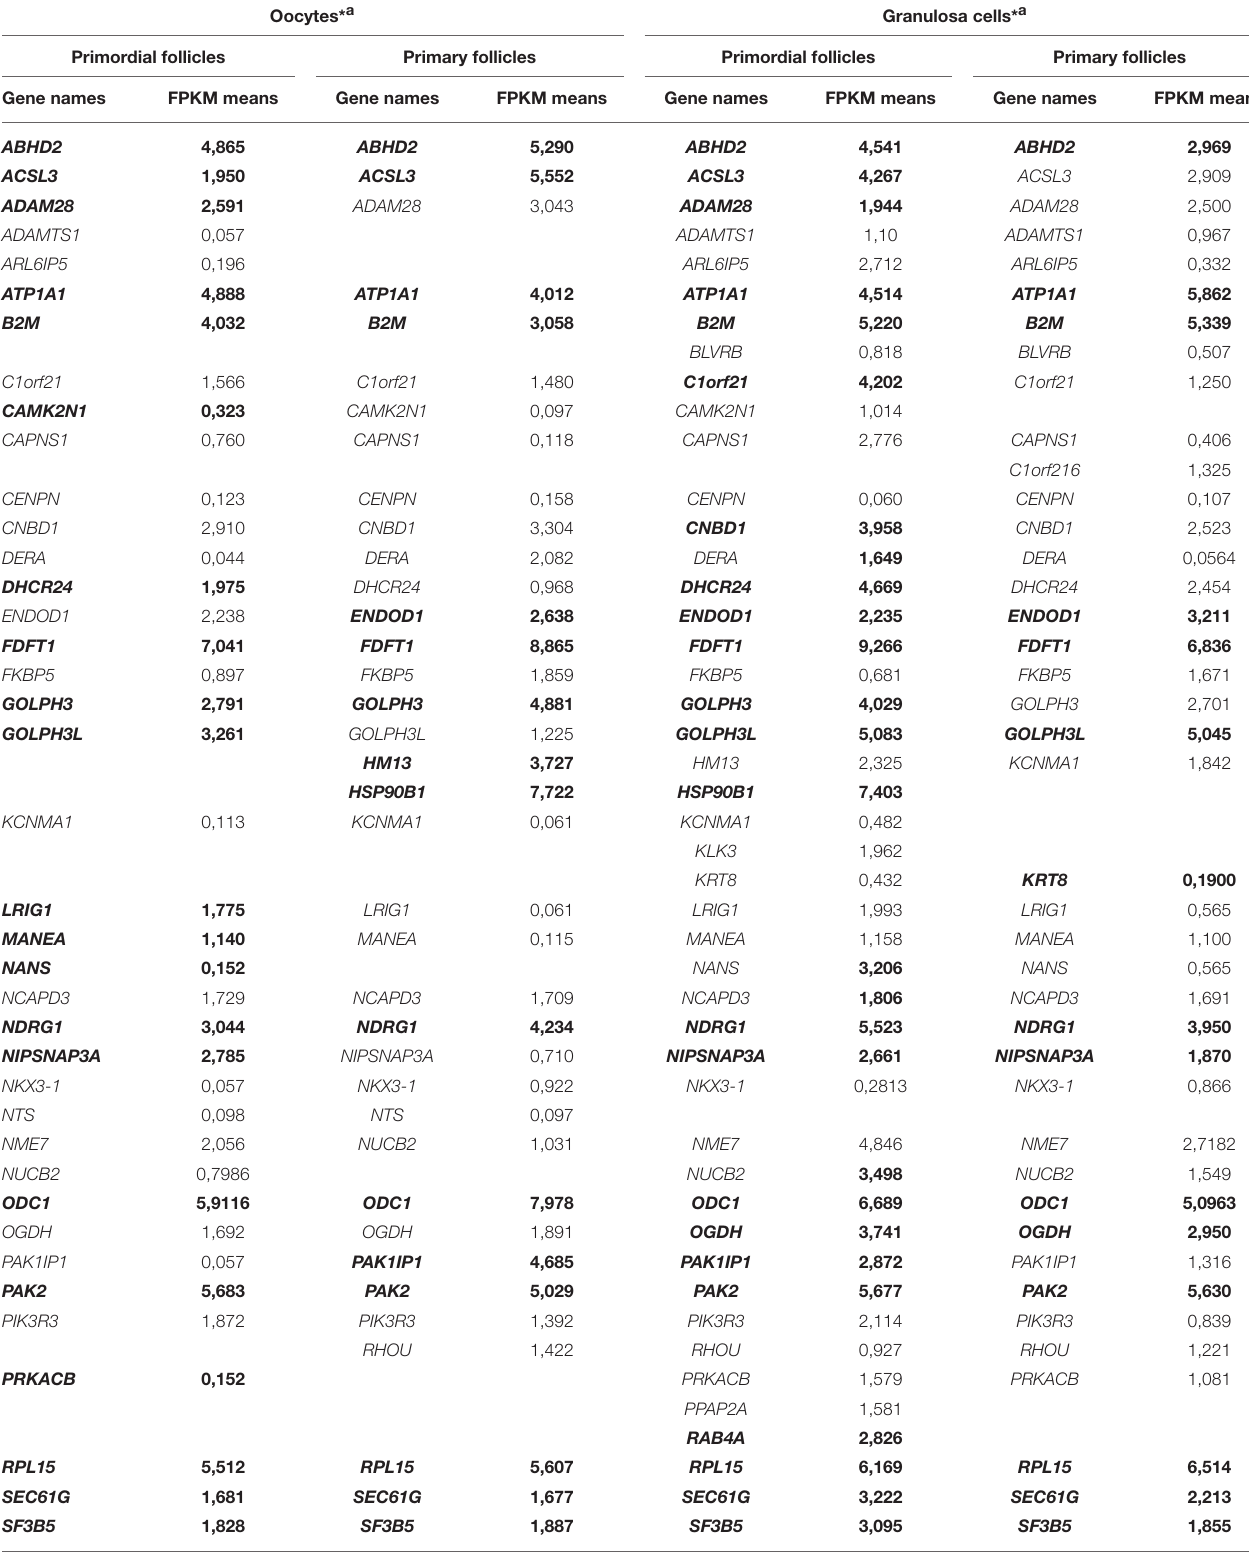
TABLE 8 | Expression of androgen-responsive